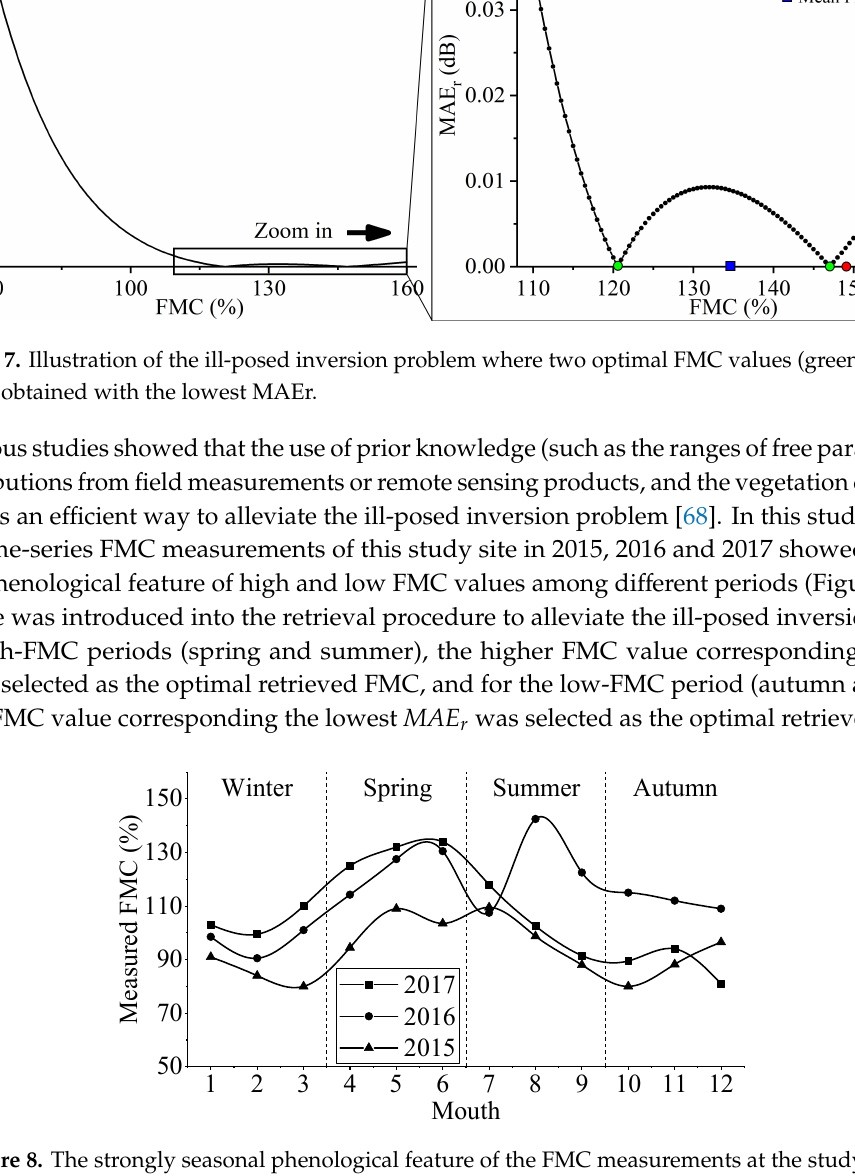
Figure 8. The strongly seasonal phenological feature of the FMC measurements at the study site.